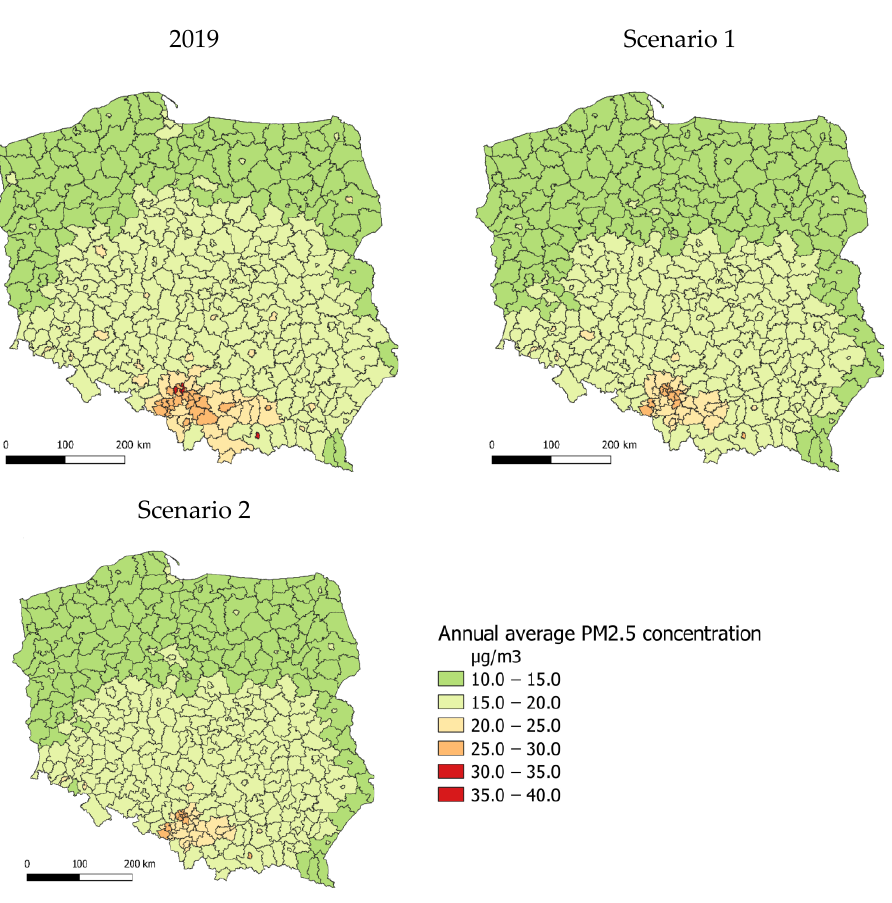
Figure 4. Spatial distribution of annual average PM2.5 concentrations in 2019 and for scenarios 1 and 2 (county average).